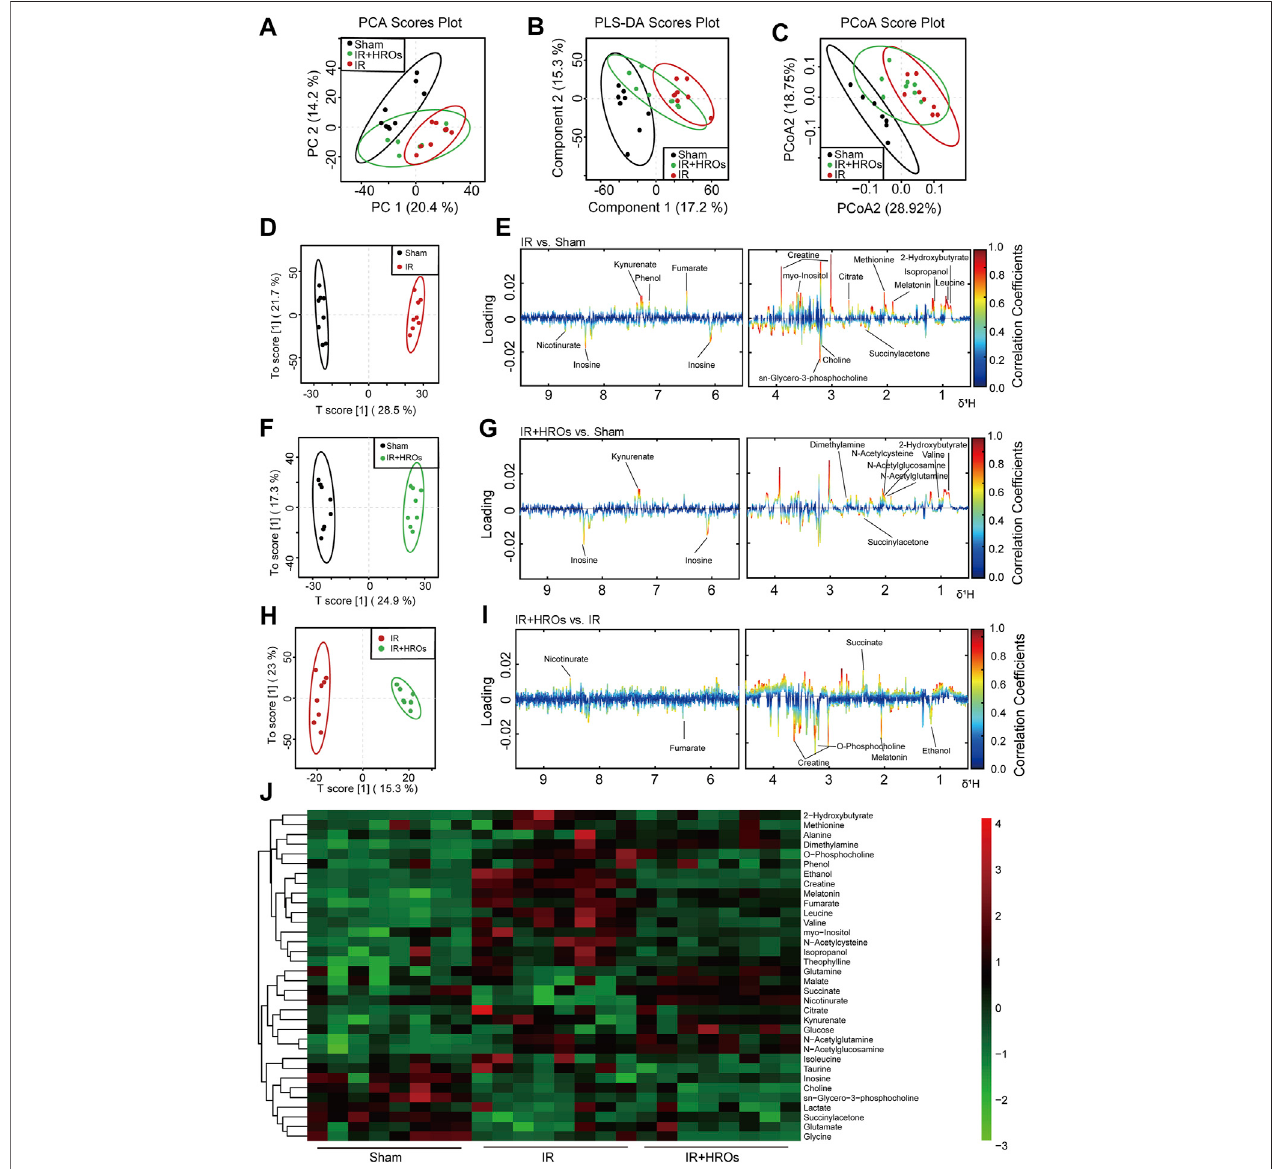
FIGURE 4 | Effects of riclinoctaose on metabolomics in the kidney. (A-C) Score plots corresponding to the PCA analysis (A), PLS-DA analysis (B), and PCoA analysis (C) of polar metabolites from the sham group, I/R group, and high-dose riclinoctaose group. (D, E) Score plots and color-coded coef fi cient loadings plots correspondingOPLS-DAanalysisofshamgroupandI/Rgroup. (F,G) Scoreplotsandcolor-codedcoef fi cientloadingsplotscorrespondingOPLS-DAanalysisofsham group and high-dose riclinoctaose (I/R + HROs) group. (H, I) Score plots and color-coded coef fi cient loadings plots corresponding OPLS-DA analysis of the I/R + HROs group and I/R group. (J) Heat map of 34 metabolites from the sham group, I/R group, and I/R + HROs group. ROs: Riclinoctaose. n (cid:1) 8. Symbols of solid black circles, solid red circles, and solid green circles represent the sham, I/R, and I/R + HROs groups, respectively.